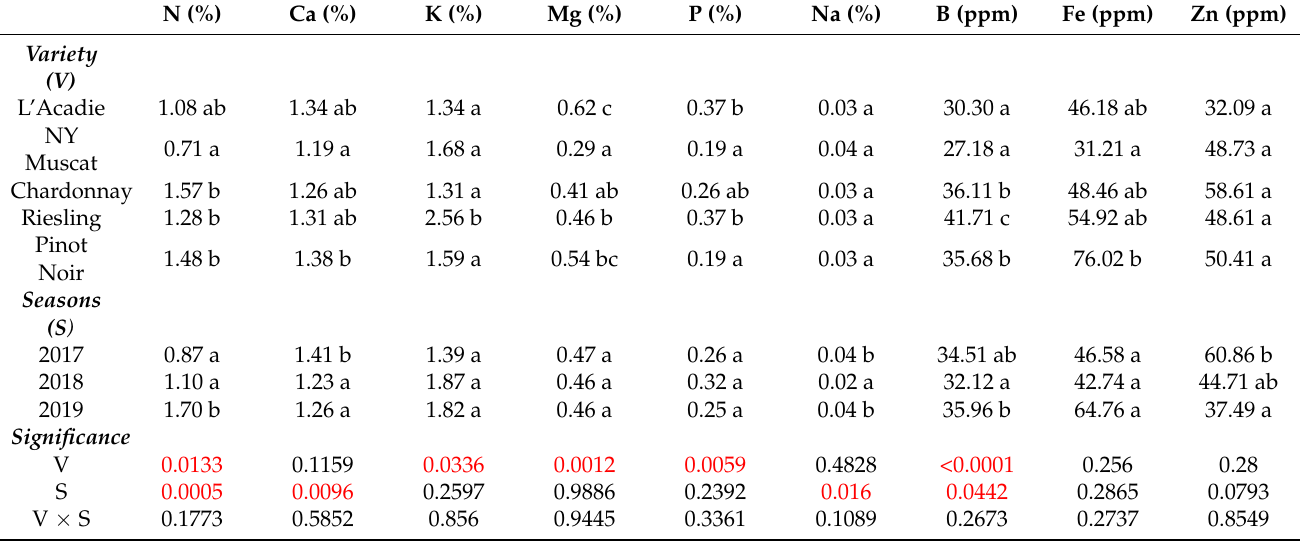
Table 4. Effects of variety on petiole nutrient content in grapevines growing under cold climate conditions over three consecutive